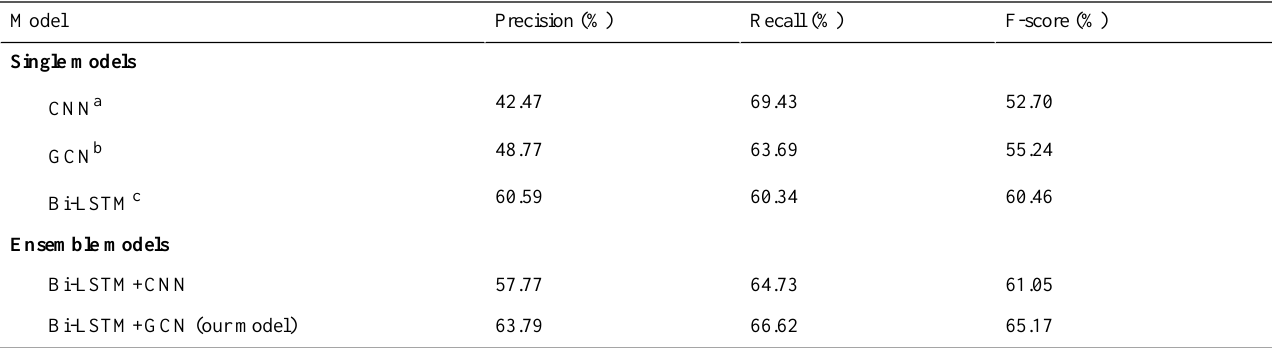
Table 5. Comparison with the baseline